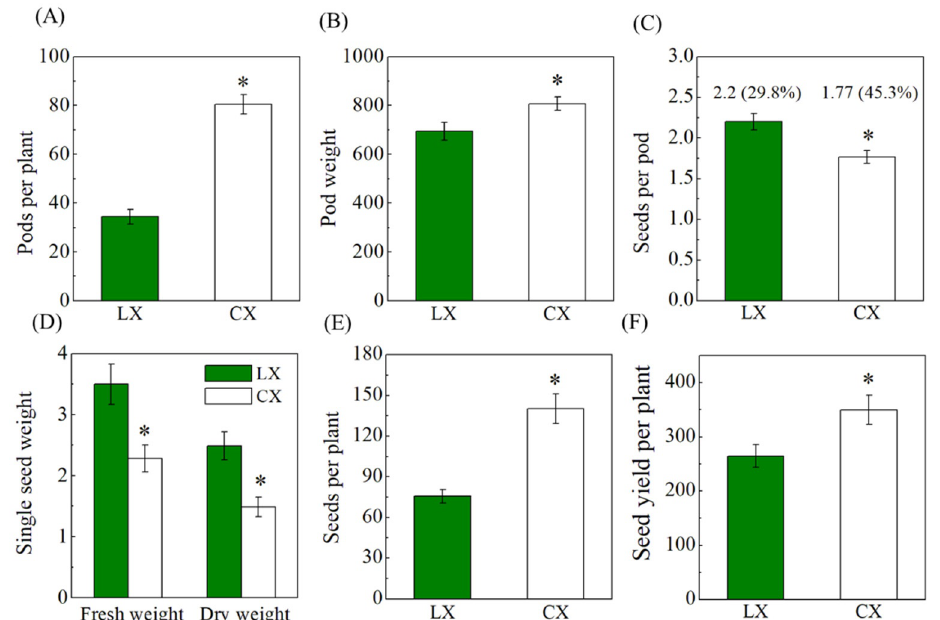
Figure 3. Comparison of yield components. ( A ) Pods per plant, ( B ) pod weight, ( C ) seeds per pod and single seed/pods ratio, ( D ) single-seed fresh and dry weight, ( E ) seeds per plant, and ( F ) seed yield per plant between Cixidabaican (CX) and Lingxiyicun. The percentage value in ( C ) means the single-seed pods ratio. * Represents significant difference between Cixidabaican and Lingxiyicun by Student’s t -test at p ≤ 0.05.